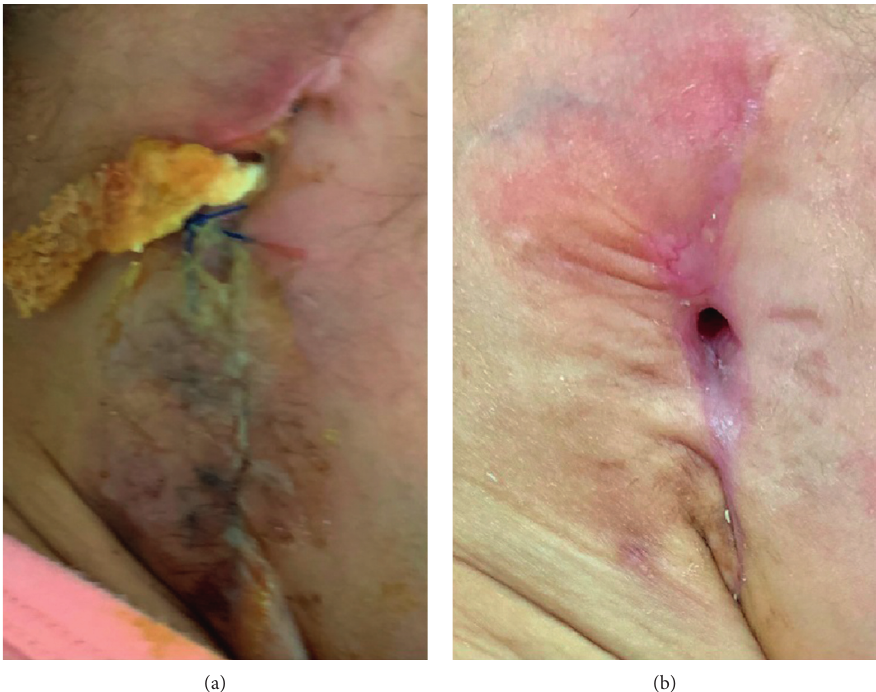
Figure 8: (a) Day 2 postoperatively showing packing of the ear and suture. (b) Day 45 postoperatively, showing complete healing of the wound with no discharge or inflammatory signs.